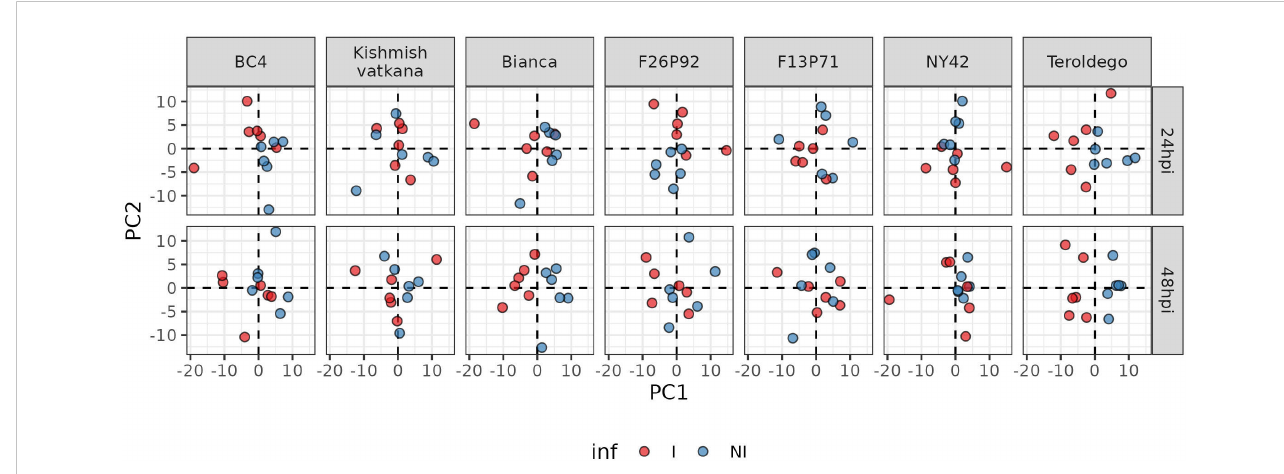
FIGURE 3 Principal component analysis performed on the log 10-transformed metabolite concentration of 24 and 48hpi samples. Each genotype has three biological replicates (small dots) for each year (2019 and 2021). The red color is for inoculated samples (I, inoculated samples) and the blue is for non- inoculated samples (NI, not inoculated